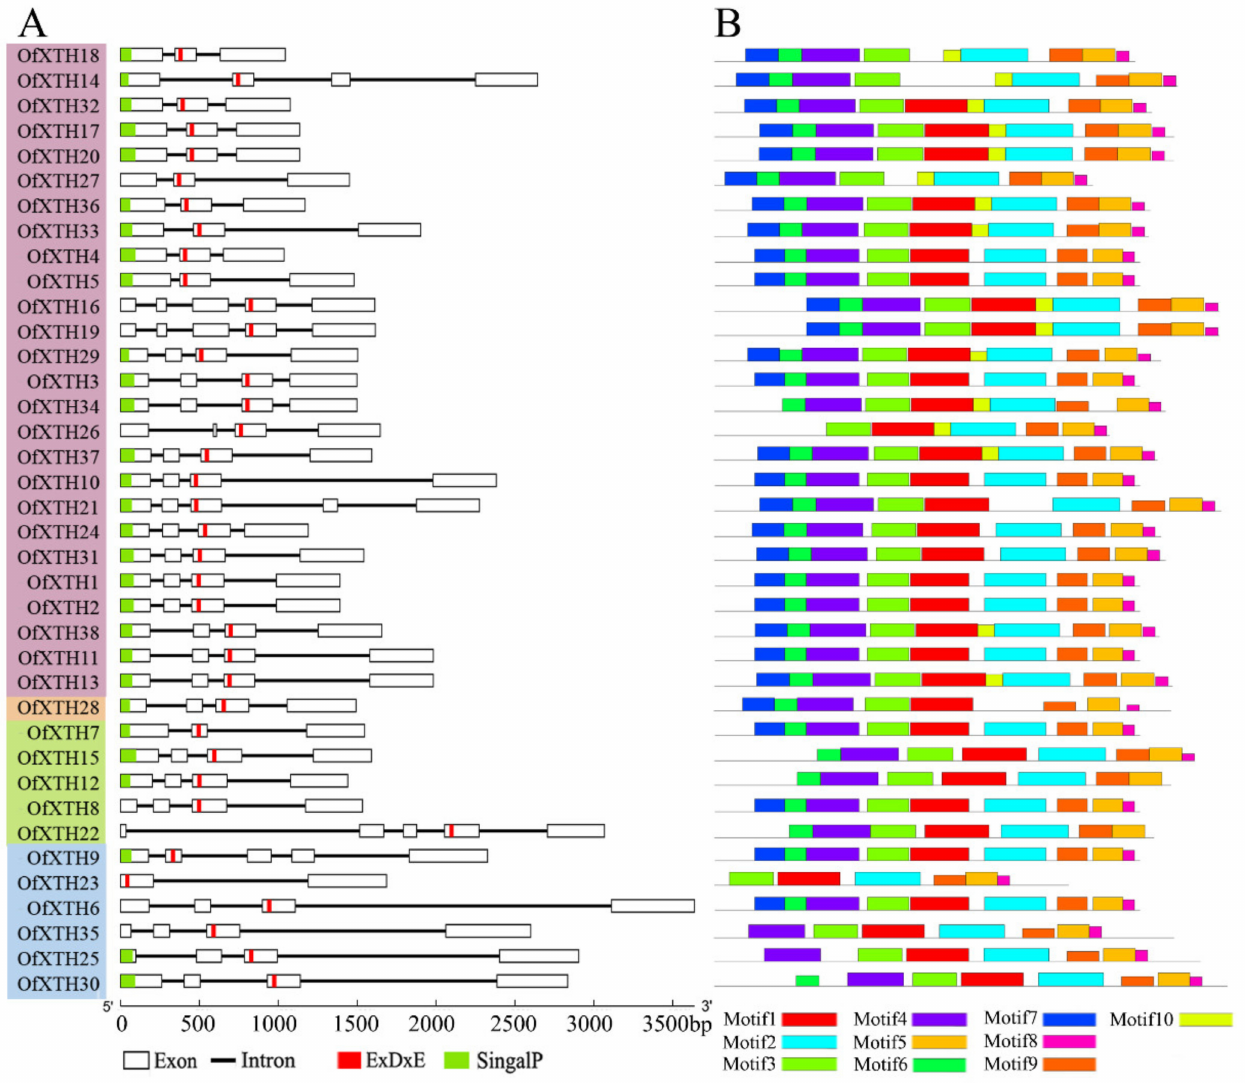
Figure 2. Gene structure and motif distribution of OfXTH proteins. ( A ) Gene structure, putative signal peptide sequences, and conservative motif sequence. Each subgroup is distinguished by a different color. White boxes and black lines represent exons and introns, respectively. The green and red strips indicate putative signal peptide sequences and conservative motif sequence, respec- tively. ( B ) The motif distribution. Motifs 1–10 in the OfXTH proteins are represented by different colored